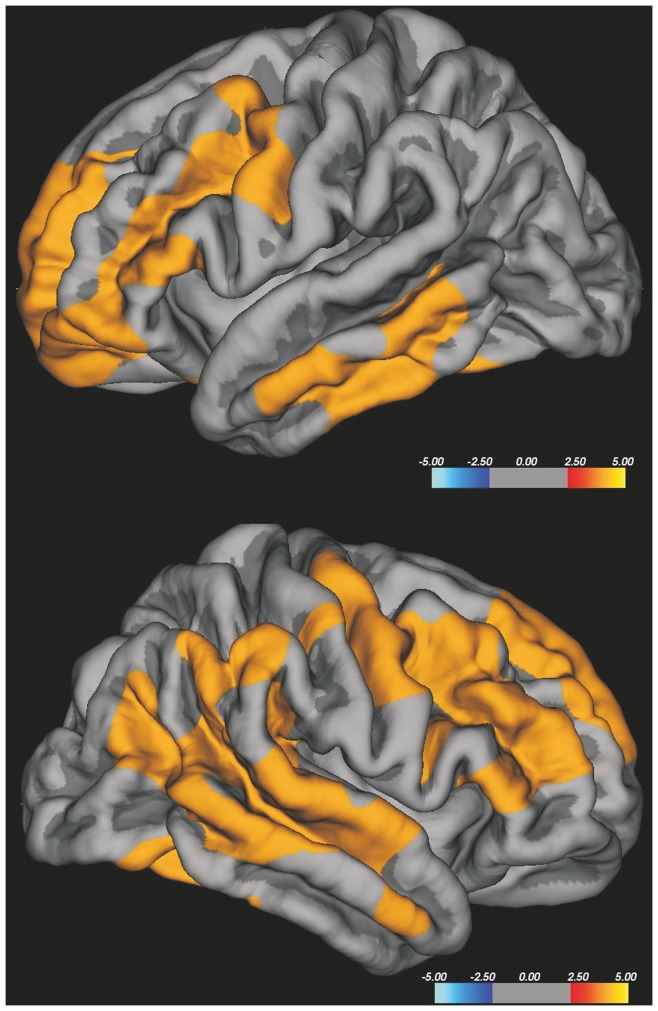
Vertex-wise analysis of CTh in ALS patients with faster progression compared to HC.Faster progressing ALS patients showed relevant thinning in widespread bilateral frontal and temporal areas, including the bilateral precentral gyrus. The colour bar scale represents t values.